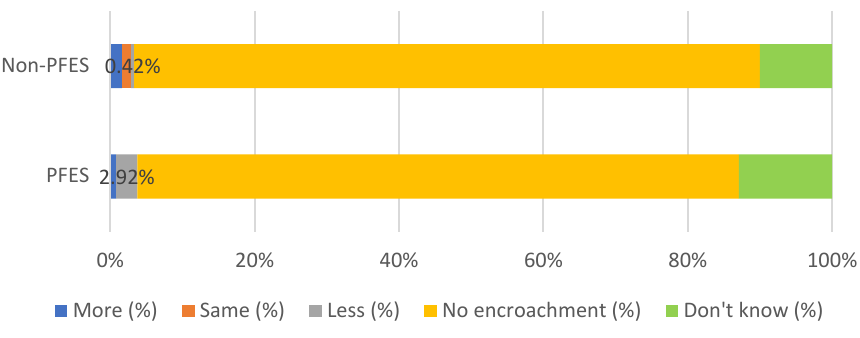
Figure 9. Extent of forest encroachment compared to before PFES.